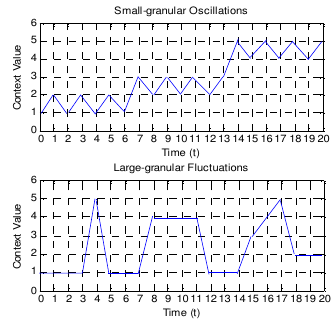
Fig. 3. Small-granular Oscillations and Large-Granular Fluctuations